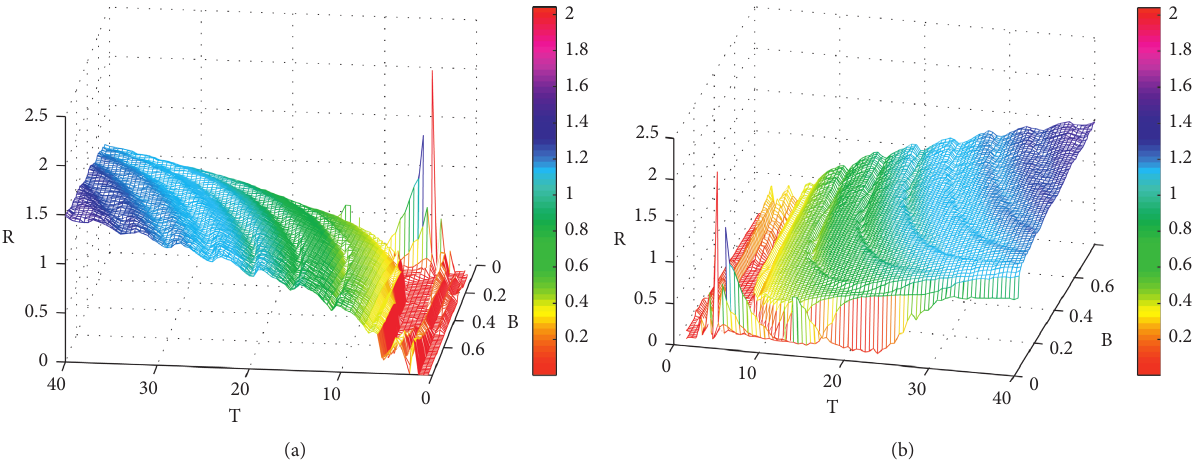
Figure 4: The parameters of the flux-controlled memristor are determined, a three-dimensional surface of FHN neuron system with coherence resonance coefficients R varying with phase noise amplitude B and period T . (a) Top view; (b) Back